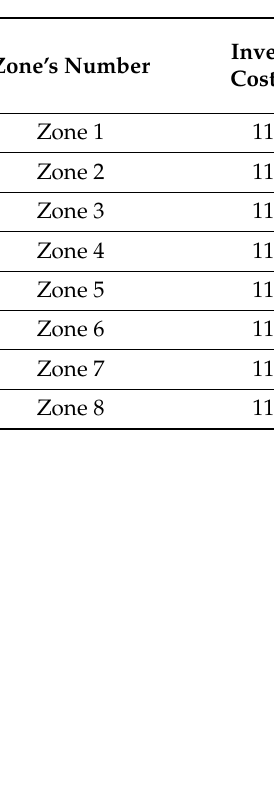
Table 6. The details of the costs/revenue in the base case.